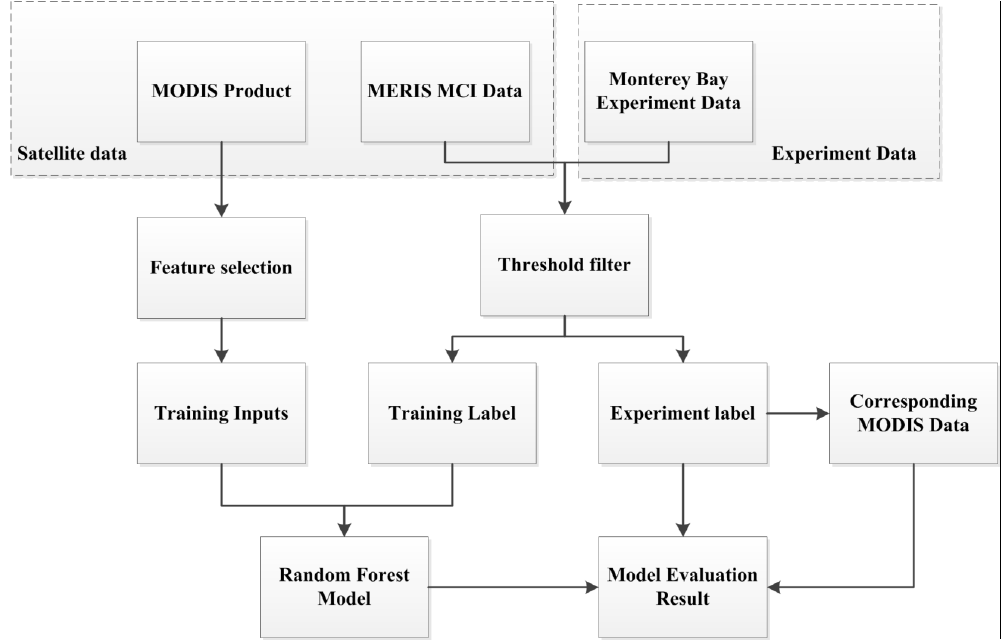
Figure 6. The framework of bloom event